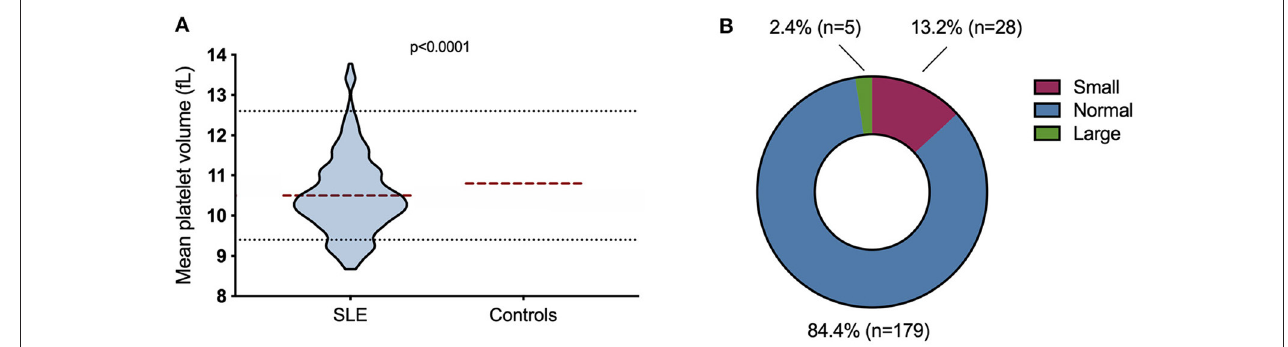
FIGURE 4 | Mean platelet volume (MPV) in SLE patients. (A) The MPV ranged from 8.7 to 13.8 fL ( n = 212). The dotted lines represent the normal range (9.4–12.6 fL). The red line represents the mean; 10.5 fL for SLE and 10.8 fL for controls. (B) MPV-values were grouped into “small,” “normal,” or “large” size MPV based on the reference interval. 2.5% ( n = 5) of the patients were large, 84.4% ( n = 179) were normal and 13.2% ( n = 28) were